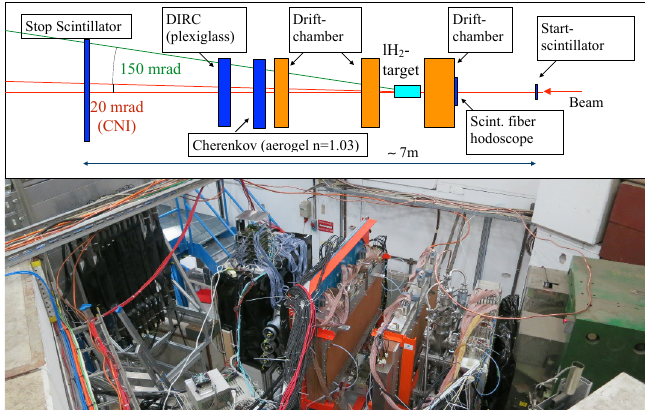
Figure 1. Detection setup for the antiproton polarization experiment with drift chambers for the track reconstruction and Cherenkov detectors for the particle identification. As target a 12 cm long liquid hydrogen volume is